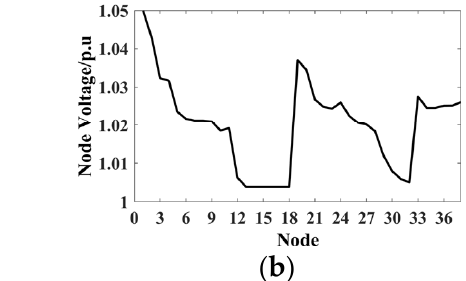
network. ( a ) Weekdays, ( b ) Weekends.